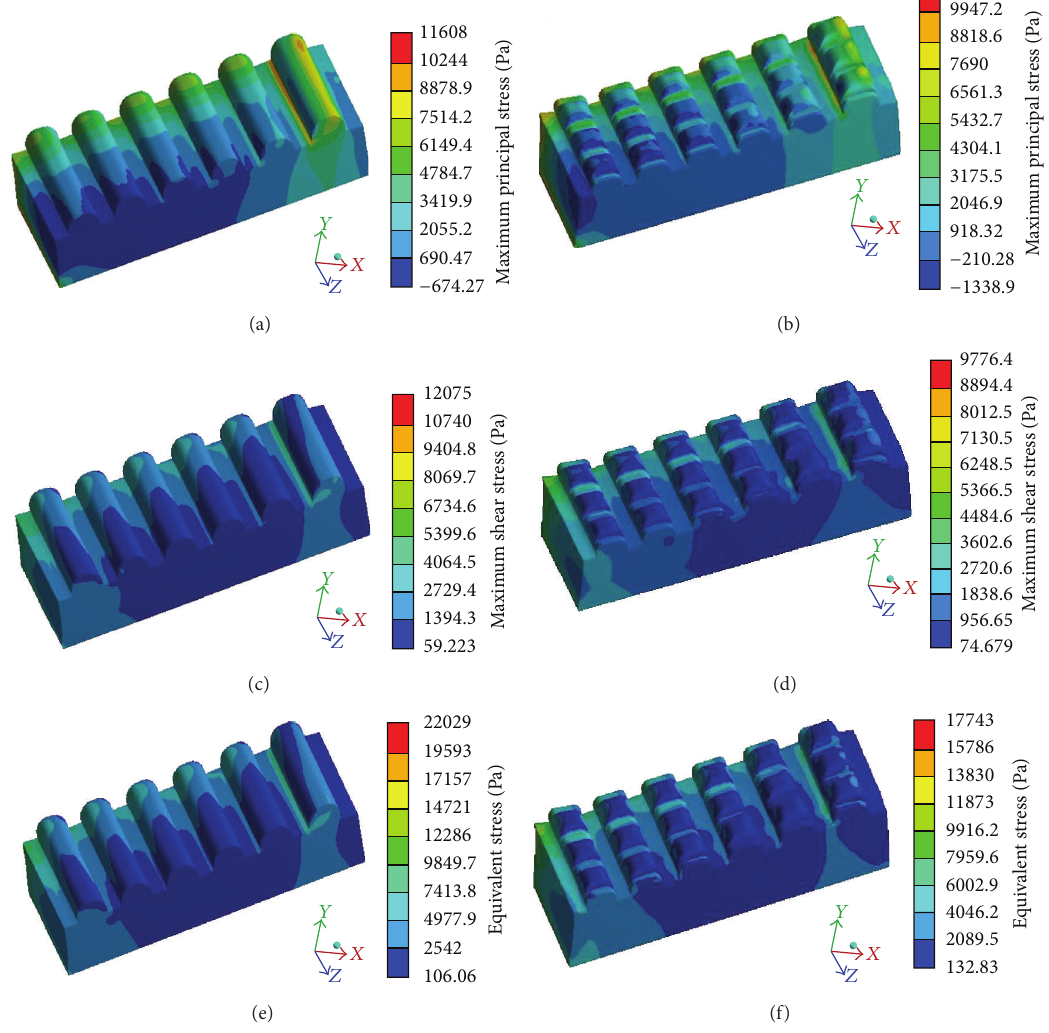
Figure 11: Different stress nephograms of the two models: (a) maximum principal stress of RMM; (b) maximum principal stress of CSM; (c) maximum shear stress nephogram of RMM; (d) maximum shear stress nephogram of CSM; (e) von Mises stress nephogram of the RMM; and (f) von Mises stress nephogram of the